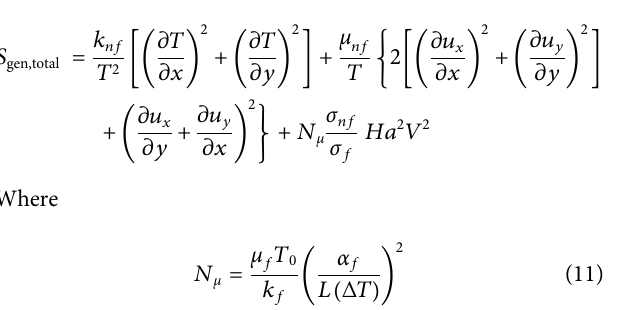
Frontiers in Physics |